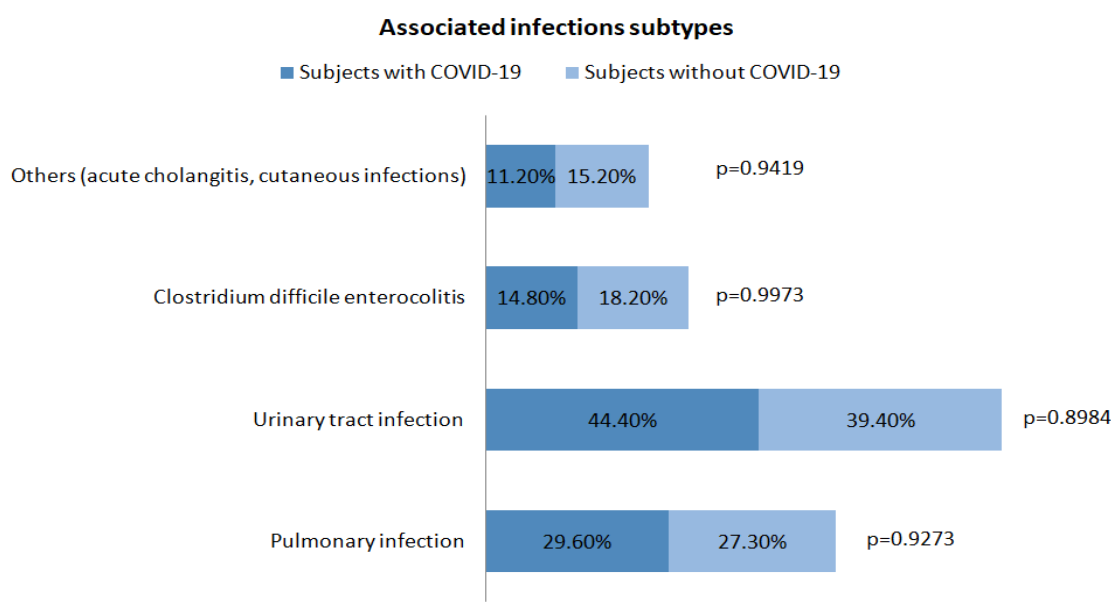
Figure 3. Associated infections occurring in the two groups.